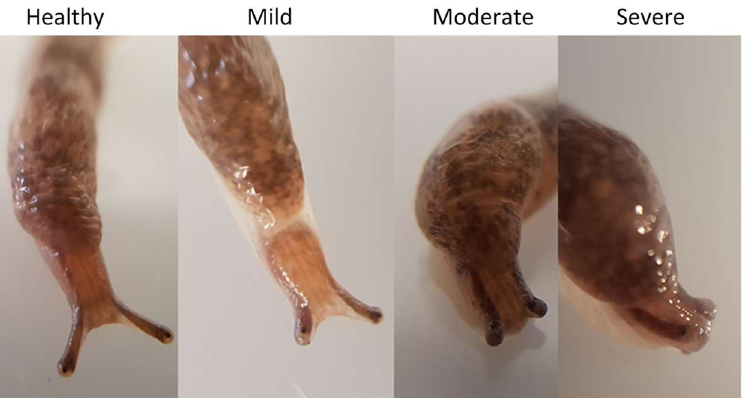
Figure 6. Slugs exposed to theronts displaying superior tentacle impairment: healthy slug not exposed to theronts; mild, moderate and severely impaired slugs after exposure to theronts.